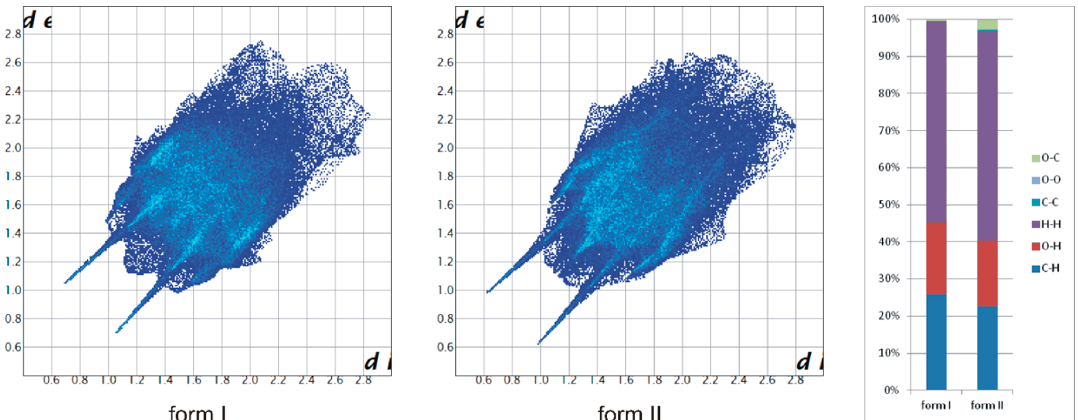
Figure 3. Contribution of intermolecular interactions to the Hirshfeld surface area calculated for polymorphs of TrCOTyr.